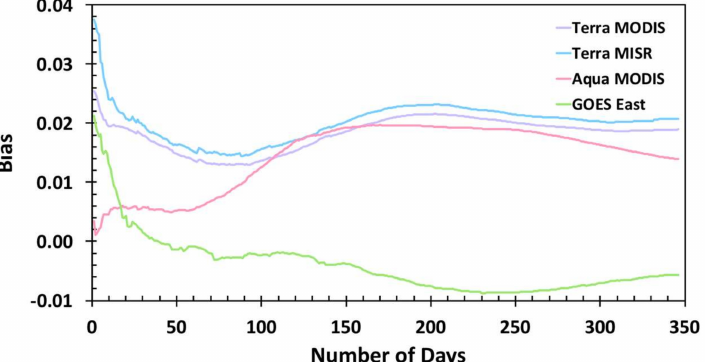
Figure 9. Mean biases at 780 nm, P 780nm ( S EOS ) − P 780nm ( S EPIC ) , as a function of averaging timescale for the MODIS, MISR and GOES East sampling areas for the period from 1 January (first point)